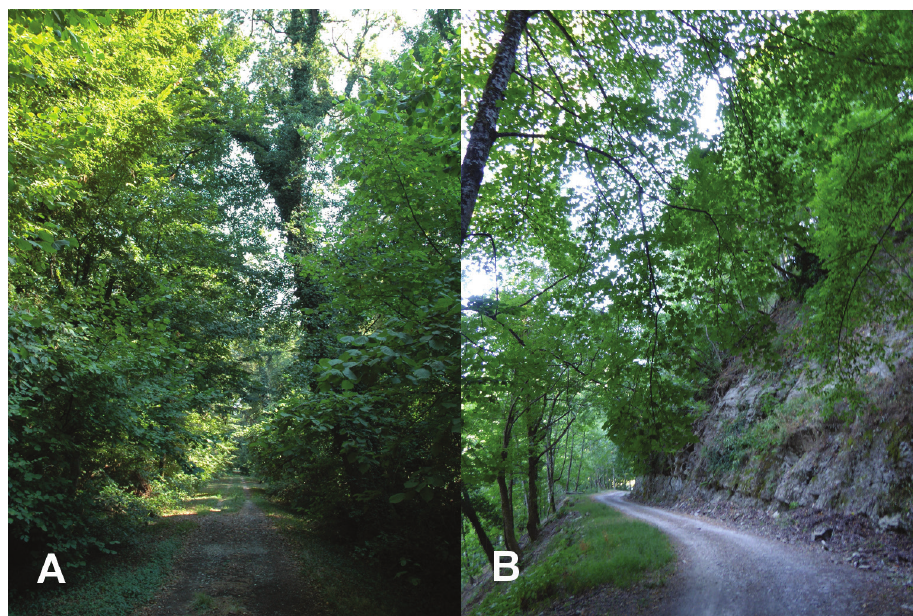
Figure 7. Examples of transect paths: A Bosco della Fontana (photo by I. Toni) B Foresta della Lama (photo by M.